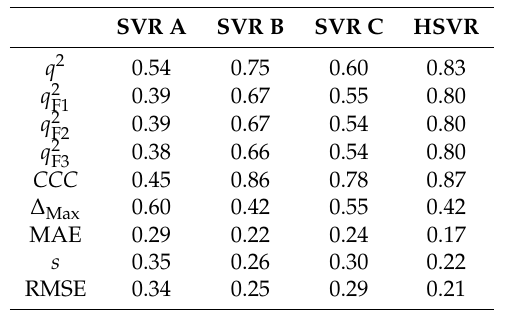
Table 3. Statistic evaluations, correlation coefficients q 2 , q 2 and RMSE evaluated by SVR A, SVR B, SVR C, and HSVR in the test